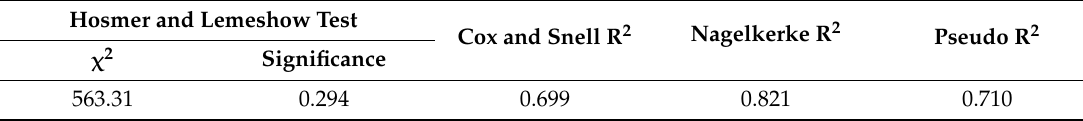
Table 4. Overall statistics of the LR model with 10 independent